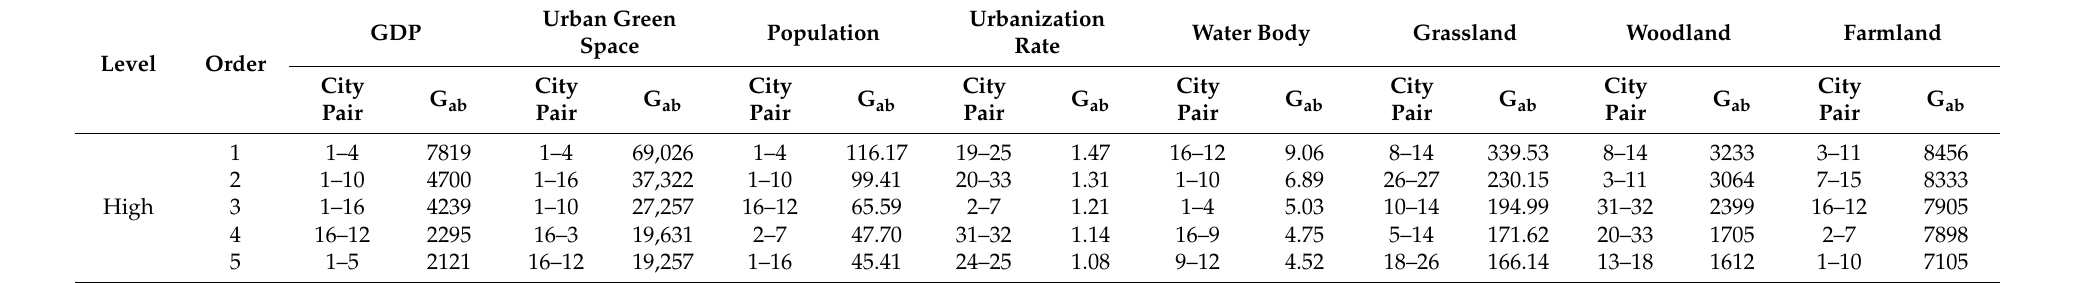
Table A2. The data details of the city pairs chosen in Figure